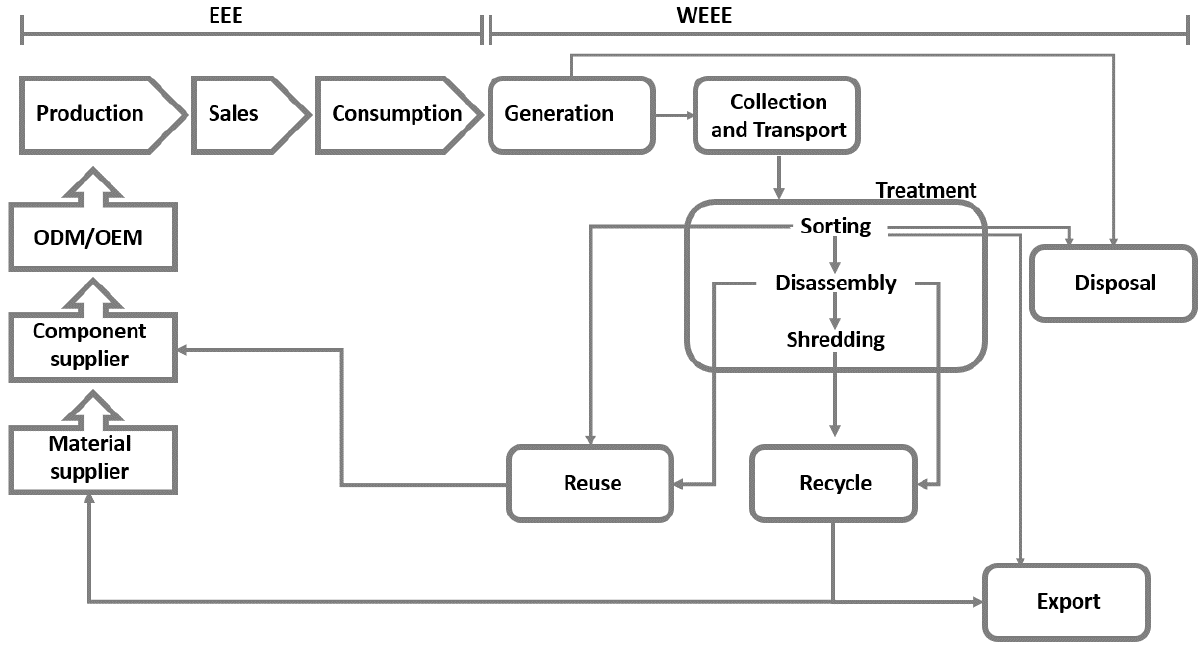
Figure 2. Supply chain structure.